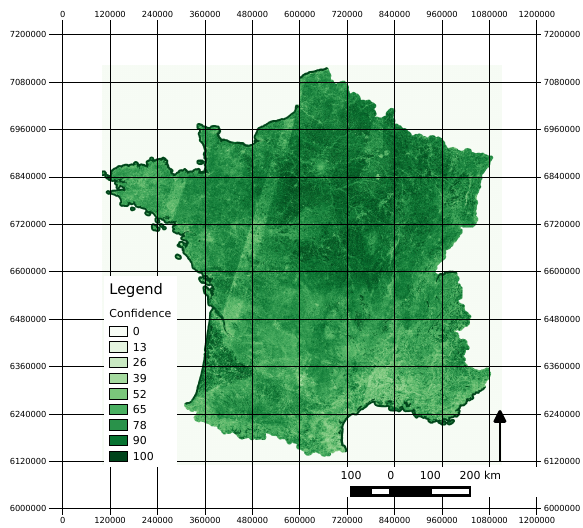
Figure 17. Confidence map: percentage of trees of the RF classifier which voted for the majority